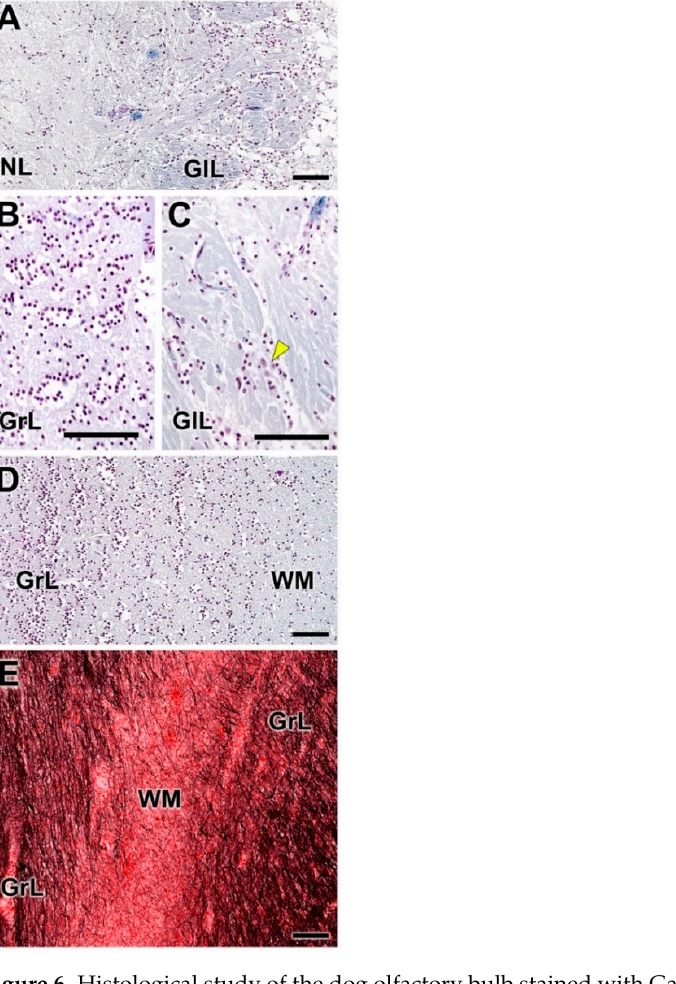
Figure 6. Histological study of the dog olfactory bulb stained with Gallego’s trichrome and Tolivia staining. ( A , C ) Nerve and glomerular layers (NL and GlL, respectively). This staining allows good definition of the periglomerular cells. At higher magnification ( C ), scattered neurons with large somas are also found (arrowhead). ( B , D ) The granular layer (GrL) is formed by clusters of granule cells. ( E ). The deep area of the OB contains the white matter (WM). Tolivia staining shows a higher density of myelinic fibres in the GrL than in the WM. Scale bars: 100 µm.